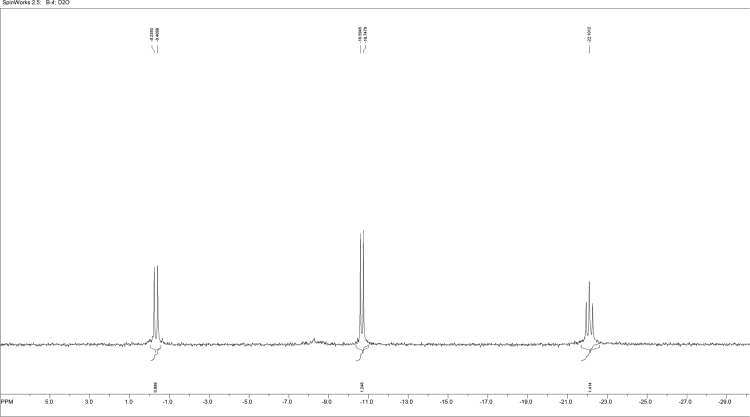
31P NMR spectrum of L~pppddU.